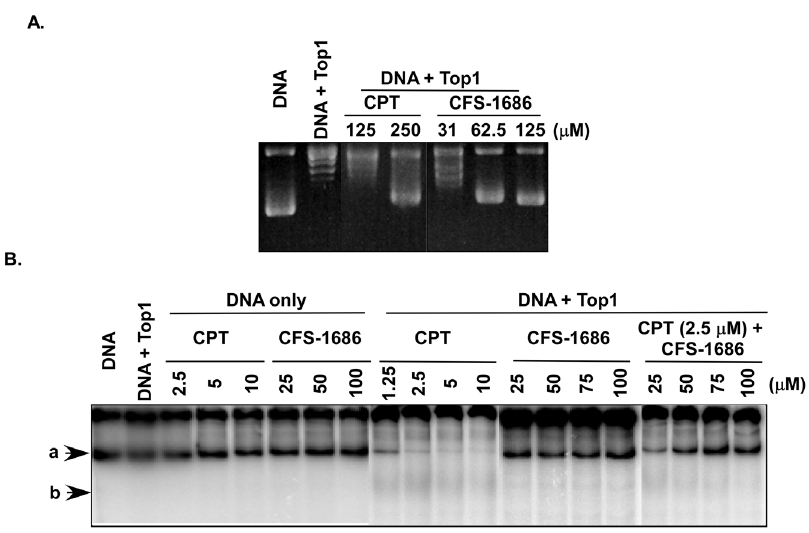
Figure 3. The effects of CFS-1686 or CPT on Top1-mediated DNA relaxation and cleavage. (A) CFS- 1686 demonstrated 4-fold higher inhibition of Top1-mediated DNA relaxation than CPT. Recombinant Top1 enzymes were incubated with plasmid pUC19 DNA with/without CFS-1686 or CPT. Agarose electrophoresis was run to resolve the supercoiling or relaxed form of DNA. (B) CFS-1686 could not induce Top1-DNAcc, but it reduced CPT-induced DNA cleavage of Top1. The recombinant Top1 enzymes were incubated with c P 32 - labelled pUC19 DNA with/without CFS-1686 or CPT. Then natural PAGE was run to resolve the intact and cleavage products. Experiments were repeated twice and representative results are shown. Arrows ‘‘a’’ and ‘‘b’’ indicate the compacted form of DNA and smear cleavage DNA, respectively.